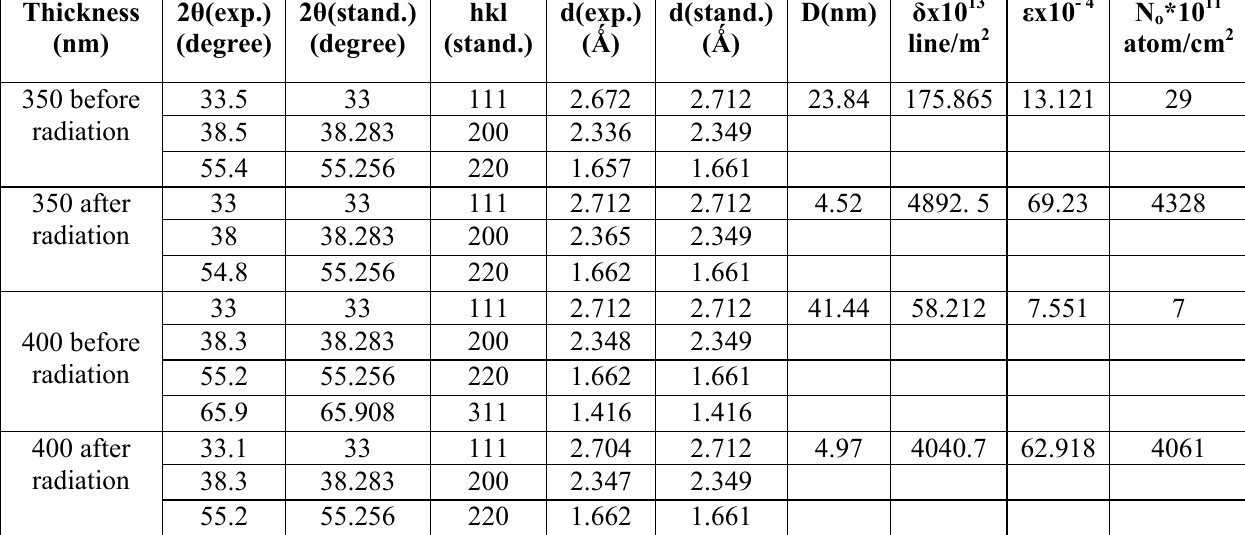
Table 1:XRD results for CdO thin films at different thickness before and after